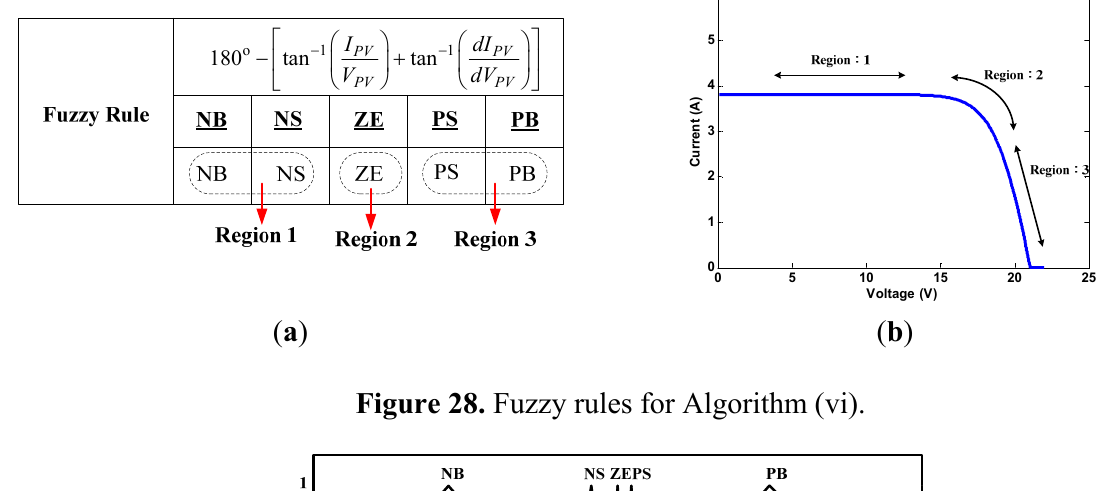
Figure 27. A concept diagram showing the corresponding Current ‒ θ —Voltage.